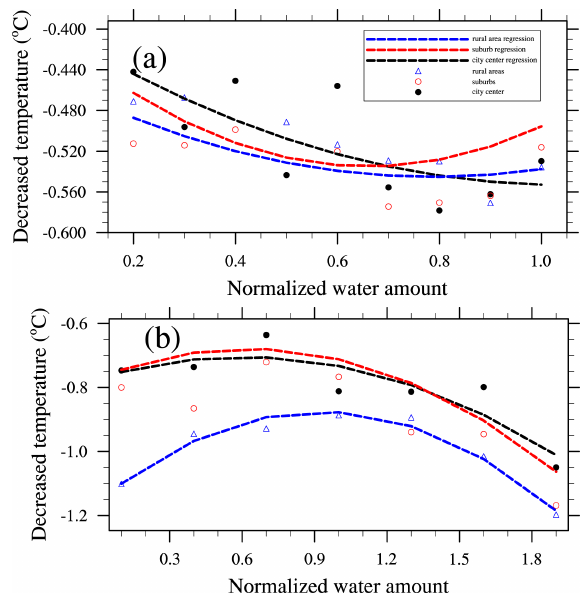
Figure 12. Relationships between the amount of water applied and the cooling effect (a) for road sprinkling and (b) for urban irriga- tion. The black dots denote the cooling effect of water applied in the city center based on model simulations, red circles denote the cooling effect of water applied in suburbs based on model simula- tions, and blue triangles denote the cooling effect of water applied in rural areas based on model simulations. The lines are polynomial regression curves, and black, red, and blue represent the city center, suburbs, and rural areas, respectively.